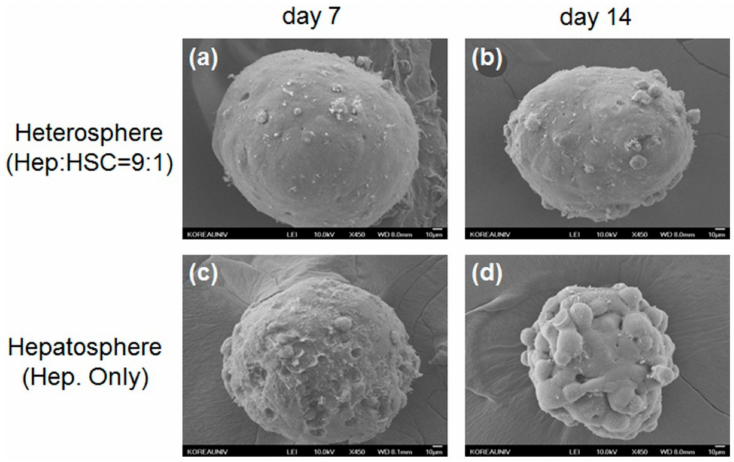
Figure 3. Scanning electron microscopy (SEM) images of heterospheres cultured for ( a ) 7 and ( b ) 14 days; hepatospheres cultured for ( c ) 7 and ( d ) 14 days. Scale bar = 10 µ